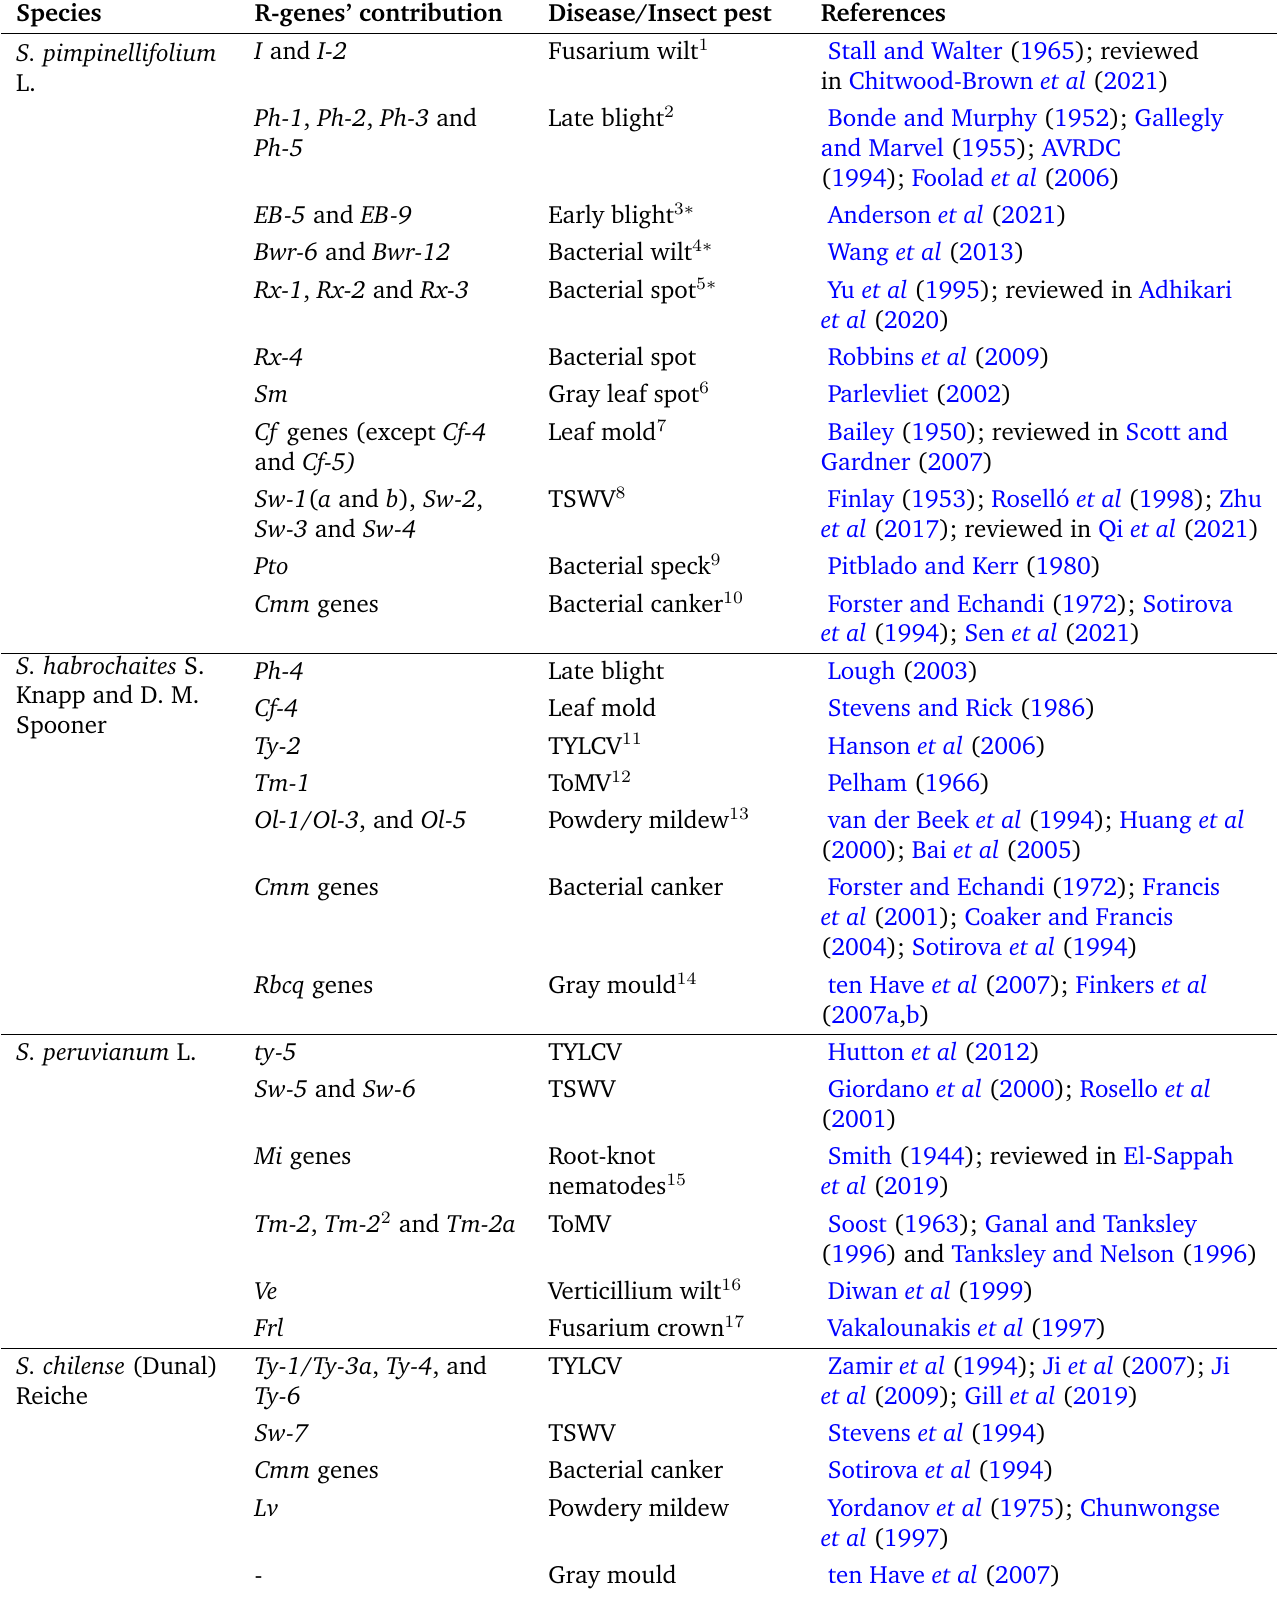
Table 2. List of major biotic resistance genes incorporated into cultivated tomatoes ( Solanum lycopersicum ) from wild relatives of tomato and S. lycopersicum var. cerasiforme . Causative agents for the listed diseases are included in